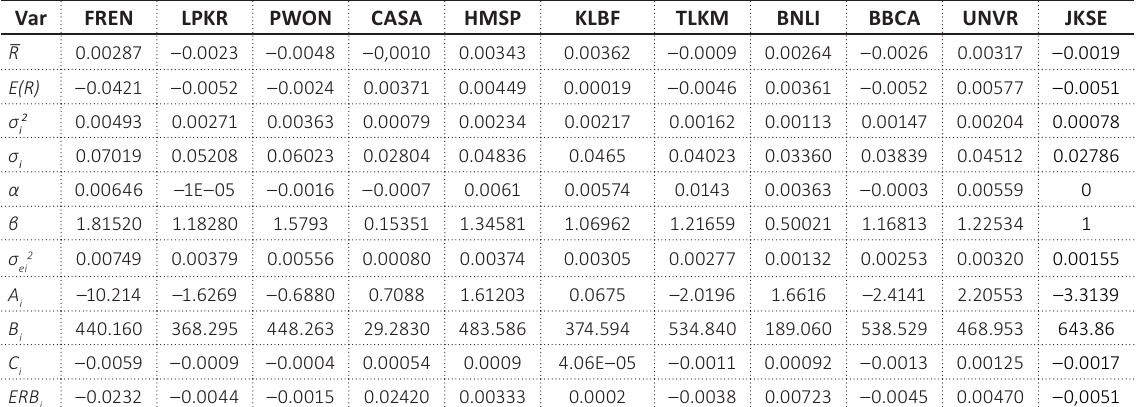
Table 3. The result of calculation of return, average return or expected return E ( R variance, standard deviation, alpha (intercept), beta (slope), of the selected samples, unsystematic , B , Ci , ERB risk, A i i i